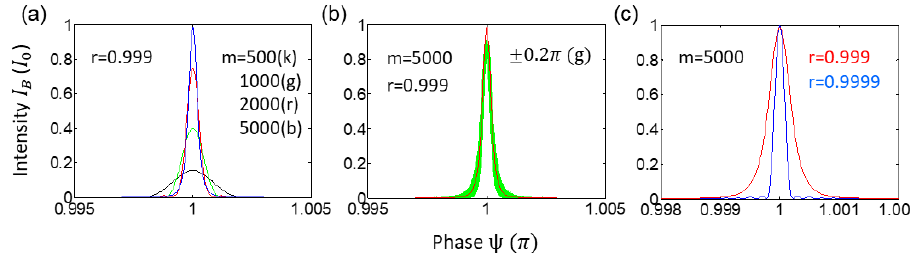
Figure 2. Numerical calculations for Equation (2). ( a , b ) Output intensities. ( c – f ) Output amplitudes. Amplitudes and intensities are normalized. Reflection coefficient is set at r = 0.999. The ring laser gain is not included. FP: Fabry – Perot interferometer.